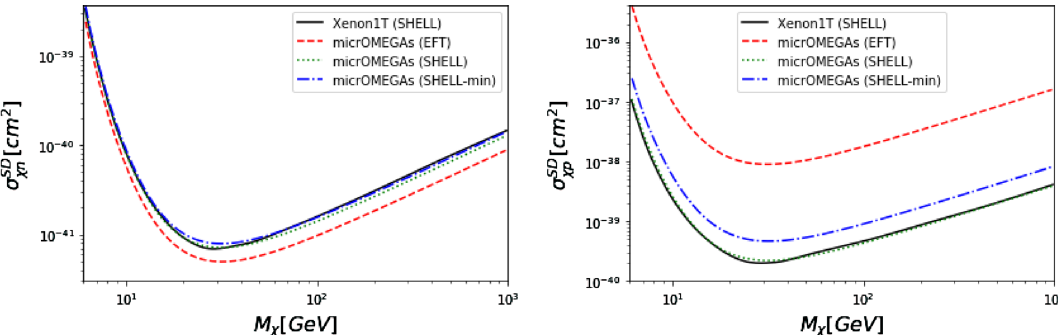
Fig. 6 Comparison of the recasted 90% limit on σ SD χ n (left) and σ SD χ p (right ) from micrOMEGAs with the XENON1T limits [2] (black) with different choices of form factors: SHELL (green/dot), SHELL-min (blue/dash-dot) [38] and EFT [39] (red/dash)